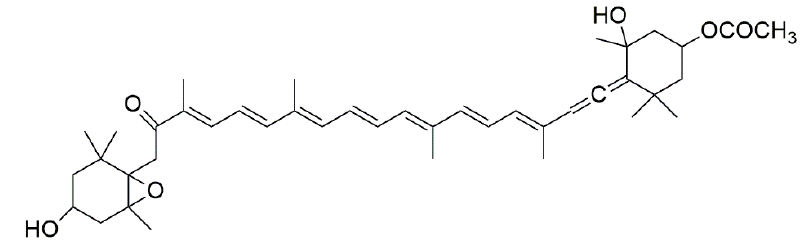
Figure 2. Fucoxanthin structure